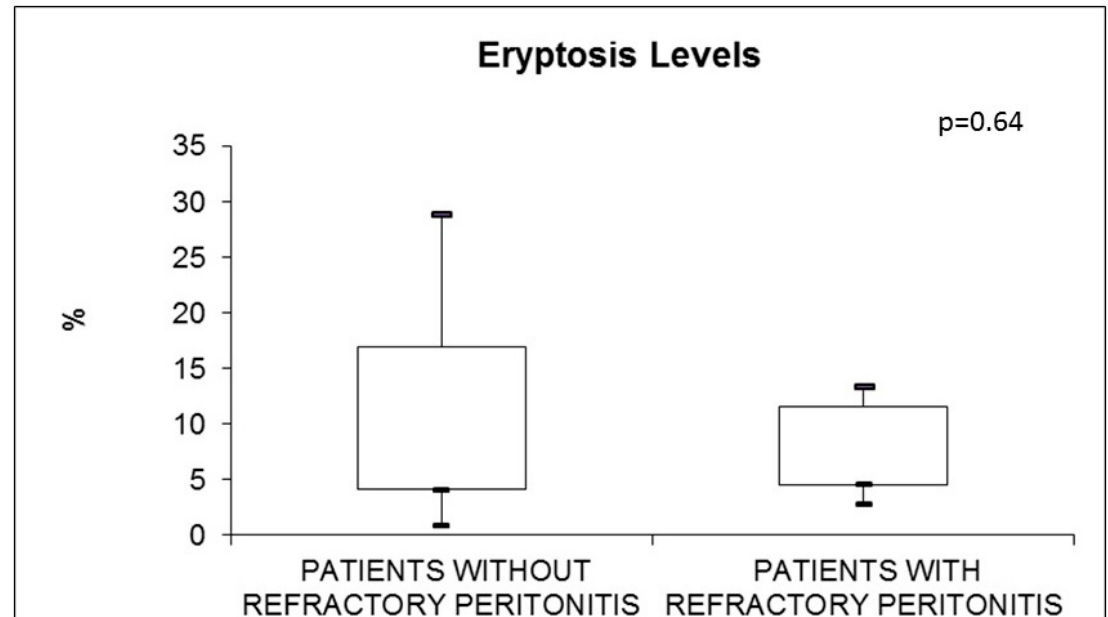
Figure 5. Eryptosis in PD subjects with (n = 6) and without (n = 25) refractory peritonitis.